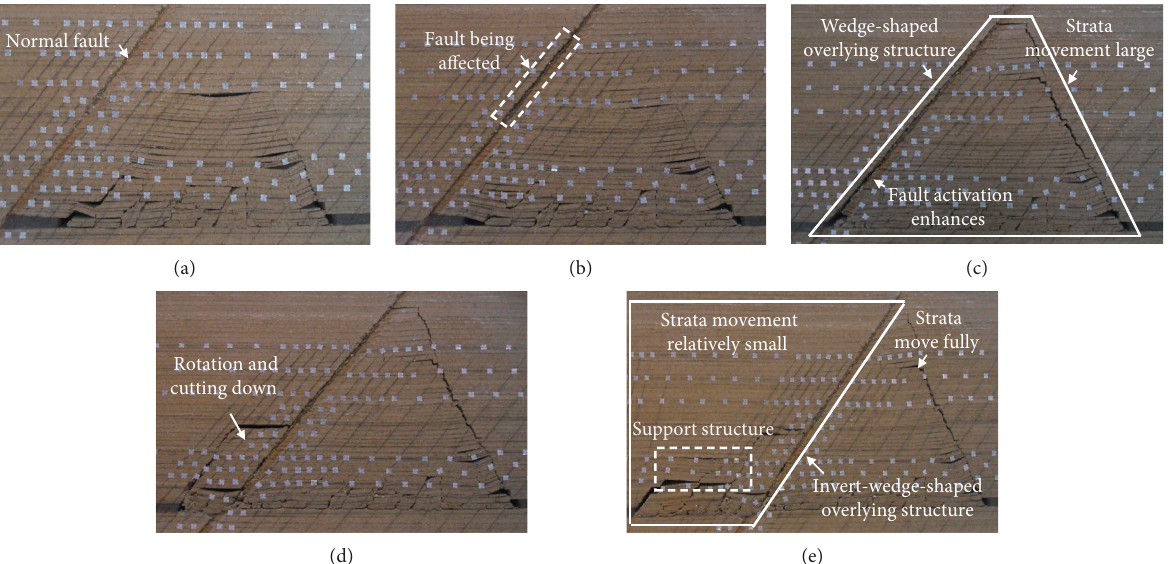
Figure 3: Structure evolution of overlying strata with mining from the footwall (Model 1). (a) L − 30m. (e) L F � − 110m.